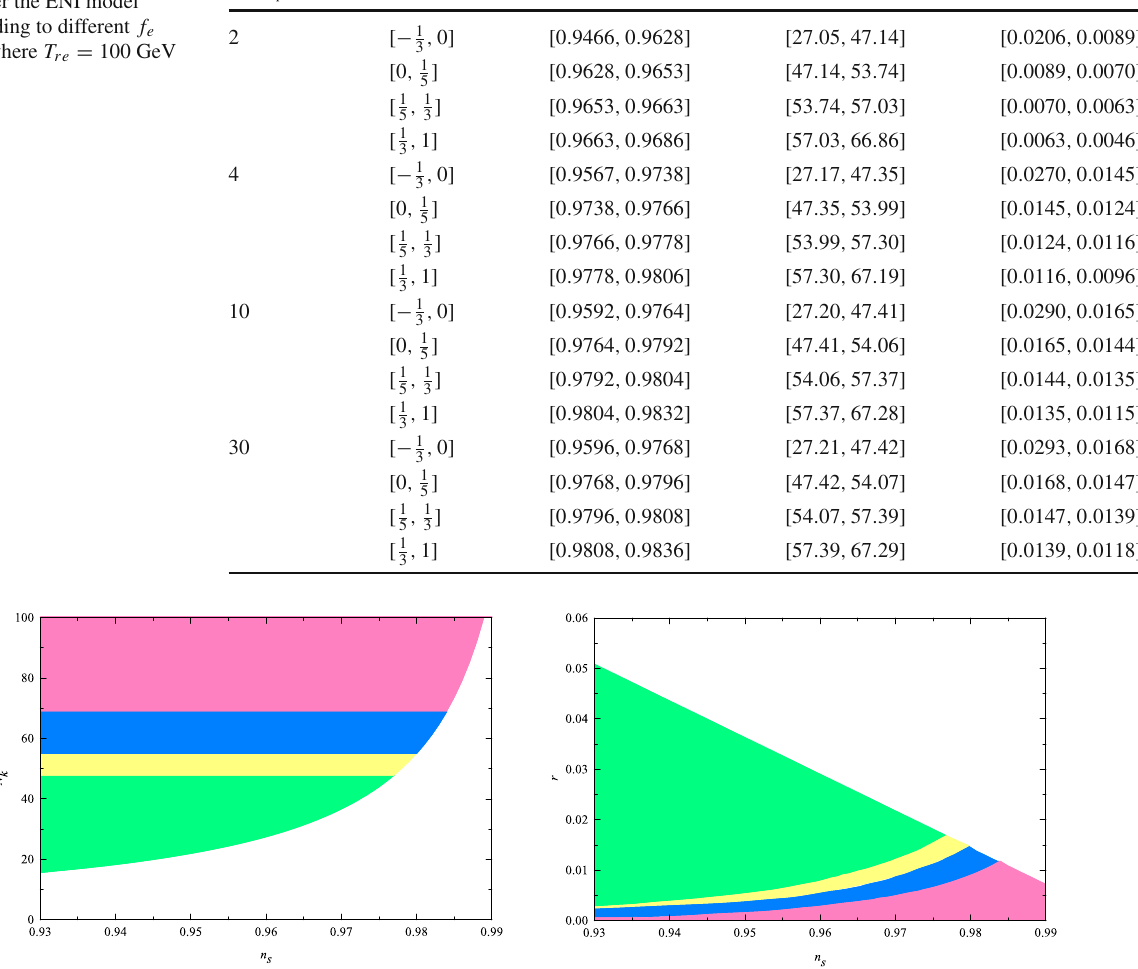
Table 2 The values of n s , N k and r under the ENI model corresponding to different f e and ω re , where T re = 100 GeV